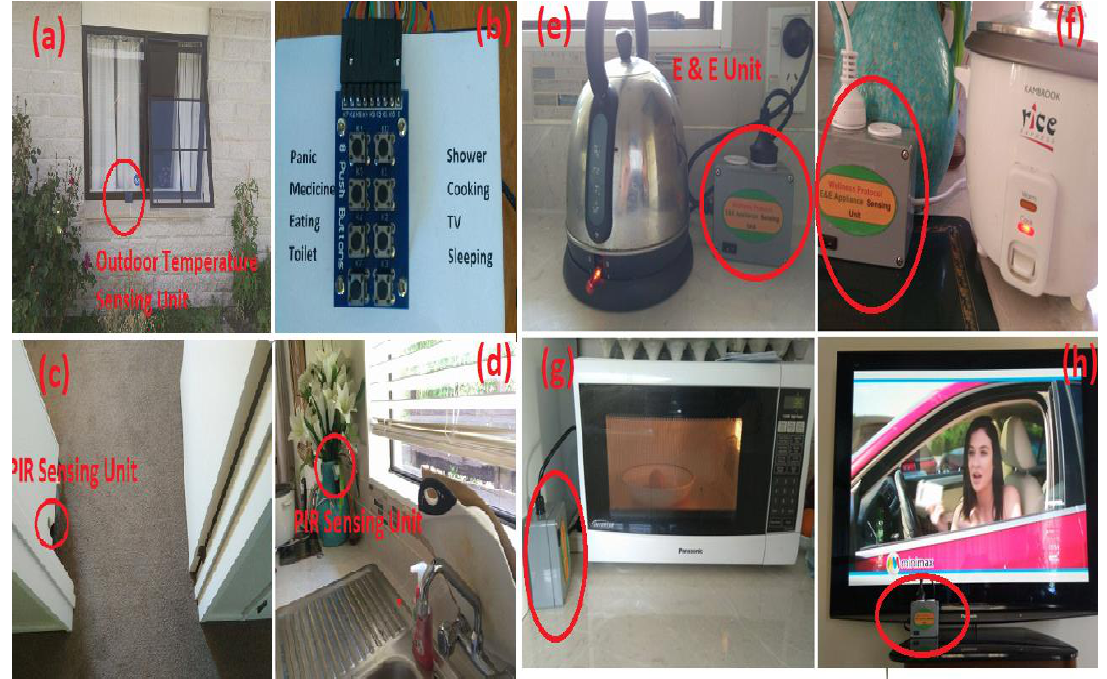
Figure 4. ( a ) Outdoor temperature sensing unit. ( b ) Activity-based manual indication unit. ( c ) Movement sensor deployed at the entry. ( d ) Movement sensor deployed at the corner of the washbasin in kitchen. ( e ) Water cattle plugged into E & E Sensor. ( f ) Rice cooker plugged into E & E Sensor. ( g ) Microwave oven plugged into E & E Sensor. ( h ) Television plugged into E & E Sensor.